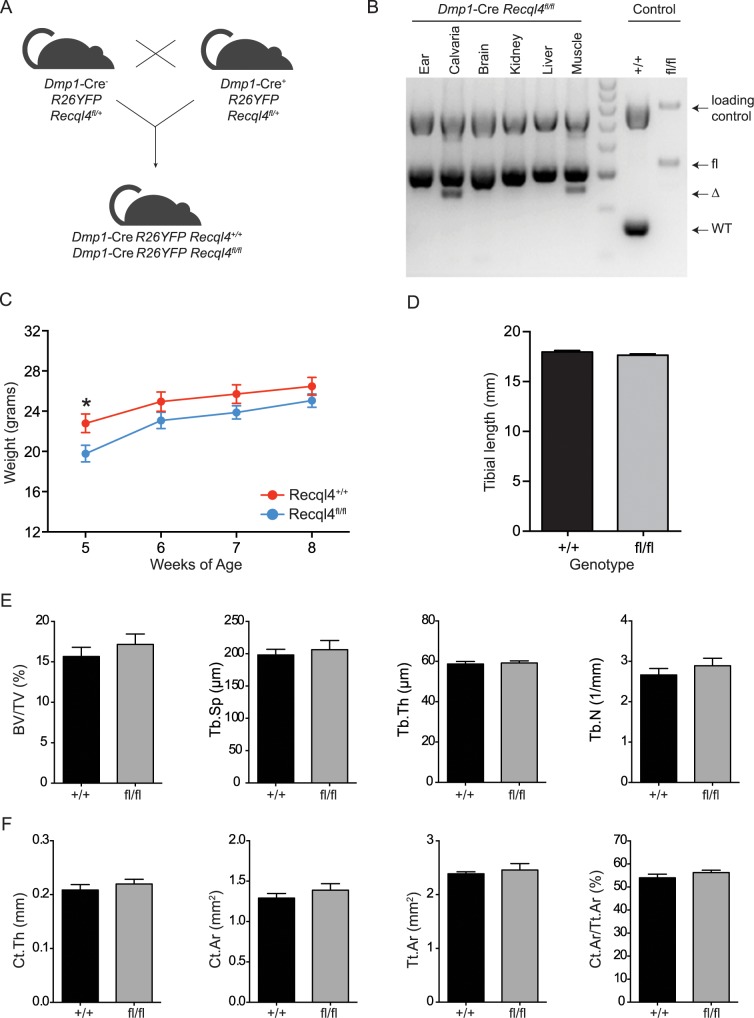

Dmp1-Cre Recql4
fl/fl mice do not display a bone phenotype.(A) Schematic of generating Dmp1-Cre Recql4
+/+ and Recql4
fl/fl mice. (B) The assessment of Recql4 genomic excision in various tissues from Dmp1-Cre mice. (C) Gross body weights of male Dmp1-Cre Recql4 mice. n = 4 for Recql4
+/+, n = 6 for Recql4
fl/fl. (D) Measurement of tibiae from Dmp1-Cre Recql4
+/+ and Recql4
fl/fl mice. n = 4 for Recql4
+/+, n = 8 for Recql4
fl/fl. (E) Trabecular bone volume (BV/TV), trabecular separation (Tb.Sp), trabecular number (Tb.N), trabecular thickness (Tb.Th) of Dmp1-Cre Recql4 tibiae. (F) Cortical thickness (Ct.Th), cortical bone area (Ct. Ar), total cortical cross-sectional bone area (Tt.Ar) and cortical bone area fraction (Ct.Ar/Tt.Ar) of Dmp1-Cre Recql4 cortical tissue. Data from 9 week old male mice; n = 4 for Recql4
+/+, n = 8 for Recql4
fl/fl. Data presented as mean±SEM. *P<0.05 compared with Recql4
+/+, t-test.